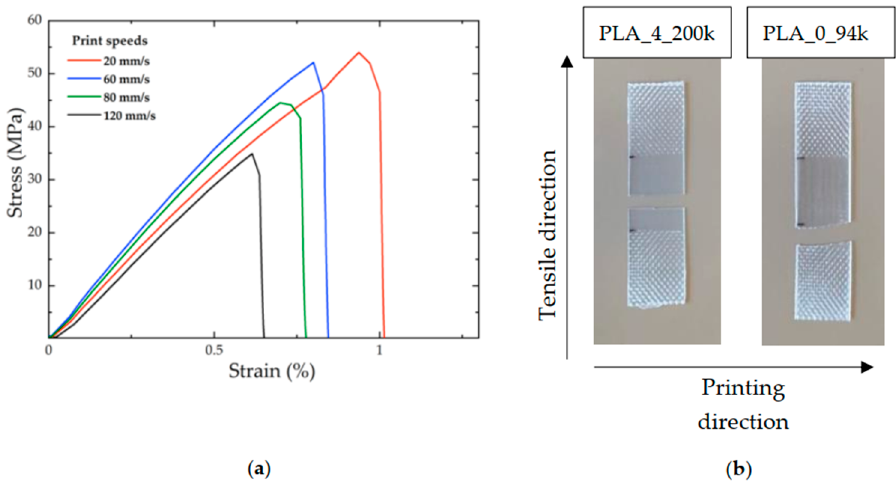
Figure 3. ( a ) Examples of stress/strain curves for PLA_4_200k samples printed at 200 °C at four different print speeds (20, 60, 80, and 120 mm/s) and for the sample obtained by compression molding; ( b ) examples of fractured samples following mechanical tensile testing for PLA_4_200k and PLA_0_94k printed at a nozzle temperature of 210 °C and print speeds of 20 mm/s and 60 mm/s, respectively.